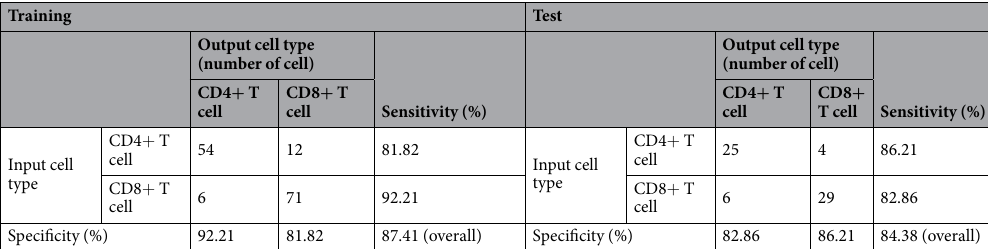
Figure 4 and Tables 1–3 illustrate the identification performance for both training and test stages. We per- formed statistical classification on three different combinations of the lymphocyte cell types: (i) binary classifica- tion of B and T lymphocytes, (ii) binary classification of the two T lymphocyte types (CD4 + and CD8 + ), and (iii) multiclass classification of all three types of lymphocytes. First, the two T cell types were considered as one class to train a binary classifier of B and T cells (Fig. 4a). The accuracy of the optimized classifier was 93.15% and 89.81%